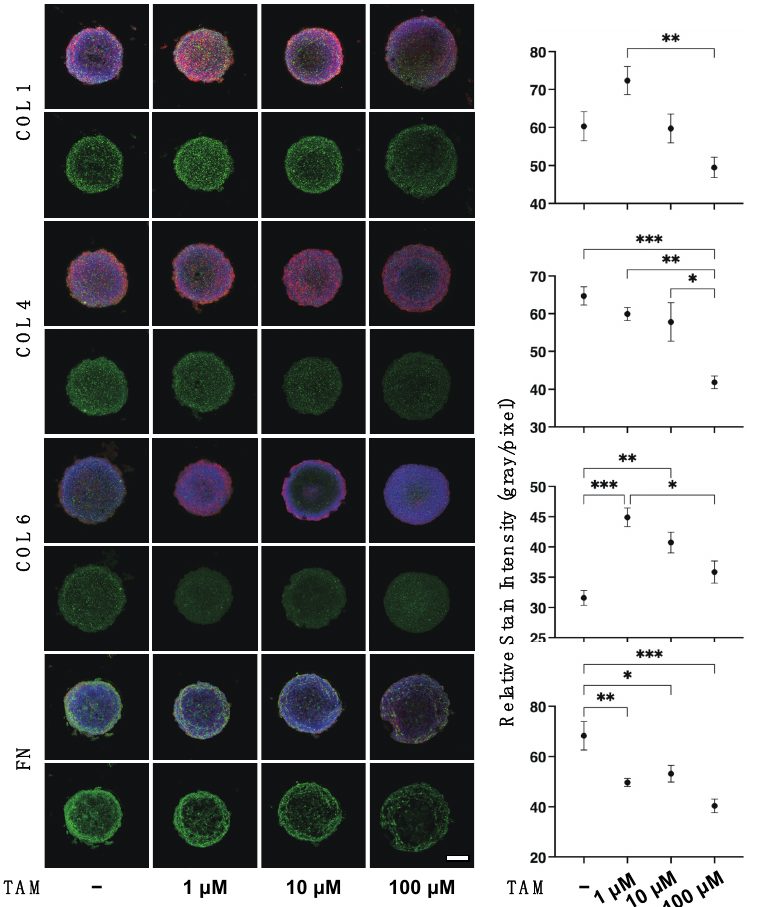
Figure 6. Representative confocal images showing the expression of ECMs in 3D ARPE 19 spheroids under several conditions. 3D ARPE 19 spheroids at Day 5 in the absence or presence of 1 μ M, 10 μ M or 100 μ M tamsulosin (TAM) were subjected to immunohistochemistry analysis. Representative immunolabeling images by specific antibodies against collagen 1 (COL 1), collagen 4 (COL 4), collagen 6 (COL6), or fibronectin (FN) (green), DAPI (blue) and Phalloidin (red) are shown in panel A (scale bar: 100 μ m). The staining intensities of the labeling of each ECM proteins were plotted in panel B. All experiments were performed in duplicate using fresh preparations consisting of 5 spheroids each. Data are presented as the arithmetic mean ± standard error of the mean (SEM). * p < 0.05, ** p < 0.01, *** p < 0.005 (ANOVA followed by a Tukey’s multiple comparison test).